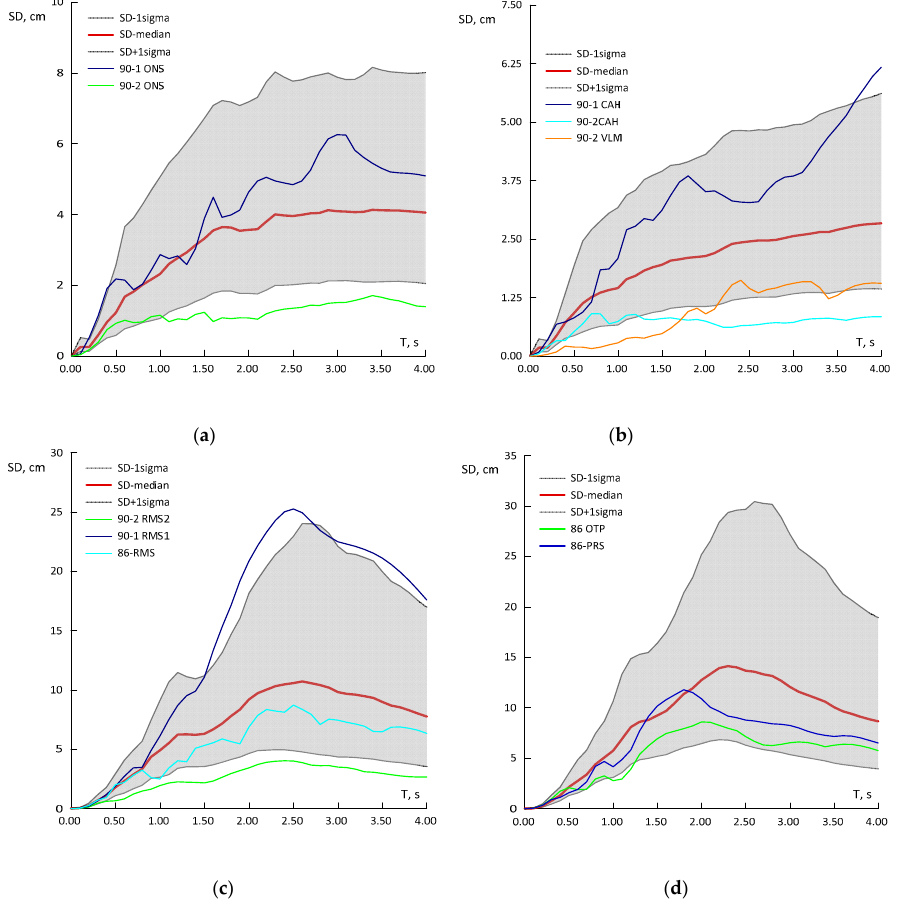
Figure 7. Predicted vs. computed displacement spectra for 1986, 1990-1 (May 30) and 1990-2 (May 31) earthquakes ( a ) 1990 events, type B soil, 50 km; ( b ) 1986, 1990 events, type B soil, 100 km; ( c ) 1986, 1990 events, type C soil, 50 km; ( d ) 1986 event, type C soil, 100 km. The thin lines represent the geometric mean of the two horizontal components for each record. The thick red line designates the median value of the predicted spectrum, whilst the grey zone encompasses a zone ± 1 σ from the median values.